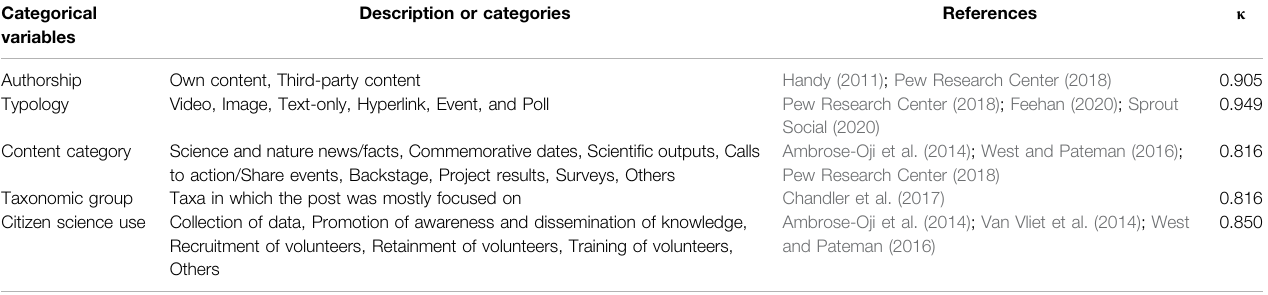
TABLE 1 | Categorical variables used in the content analysis of Facebook publications. Cohen ’ s kappa values ( κ ) were calculated using IBM SPSS Statistics (version 26) to evaluate the intercoder reliability. For more details on the coding schemes, please see Supplementary Table S1 .